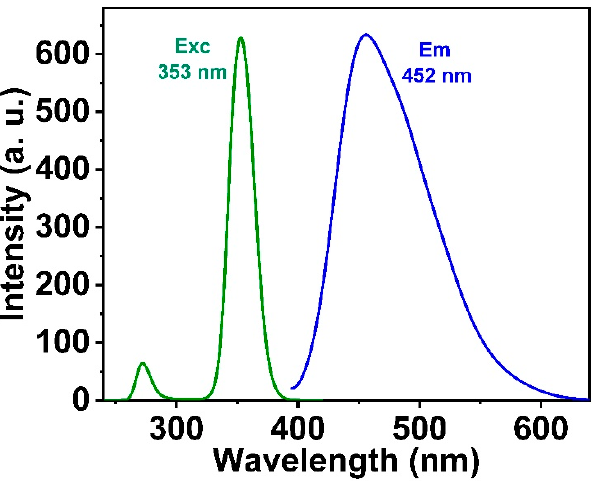
Figure 5. Excitation and emission spectra of salicylamide in aqueous solution.